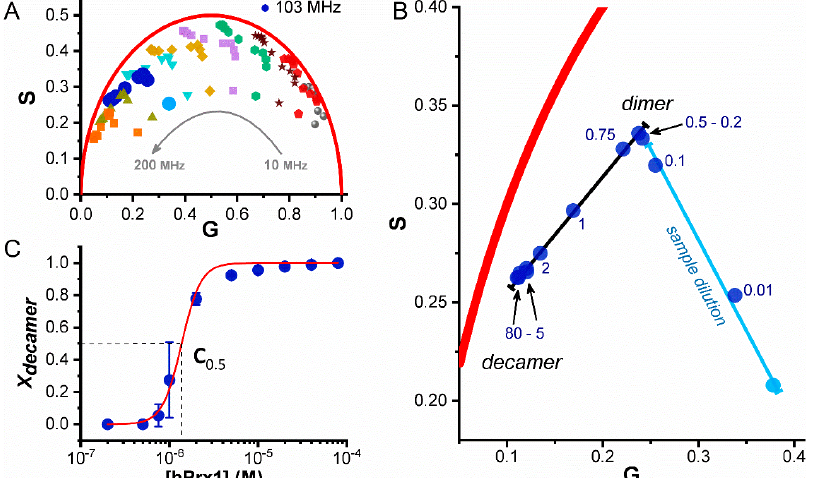
Figure 3. Dissociation of hPrx1 followed by fluorescence lifetime phasors . ( A ) Multifrequency domain (10–200 MHz) fluorescence lifetime measurements were performed at different hPrx1 concen- trations (80–0.01 µ M) and converted to phasor points. The colors represent different frequencies, and the multiplicity of points represent the different concentrations assayed. ( B ) Phasor points obtained at 103 MHz are shown. A black line connects phasor points obtained at high (80 µ M) and low (0.2 µ M) concentrations of hPrx1. Further dilution of hPrx1 led to signal loss and phasor displacement towards the buffer fluorescence (light blue line and point). The numbers indicate hPrx1 concentration ( µ M) at each point. ( C ) Data fitting to a decamer to dimer dissociation model. The fraction of decamer was calculated from the phasor coordinates using Equation (7), plotted against hPrx1 concentration, and fitted to the model (Equation (12)). Data are represented as the average ± standard deviation from three independent